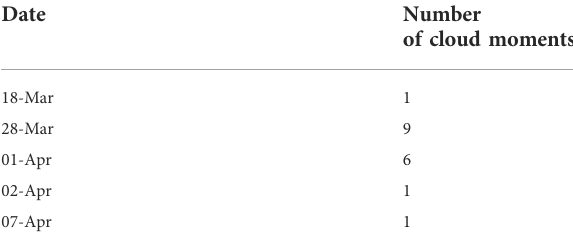
TABLE 1 Presence of clouds for 5 days:18, 28 March, and 01, 02, and 07 of April